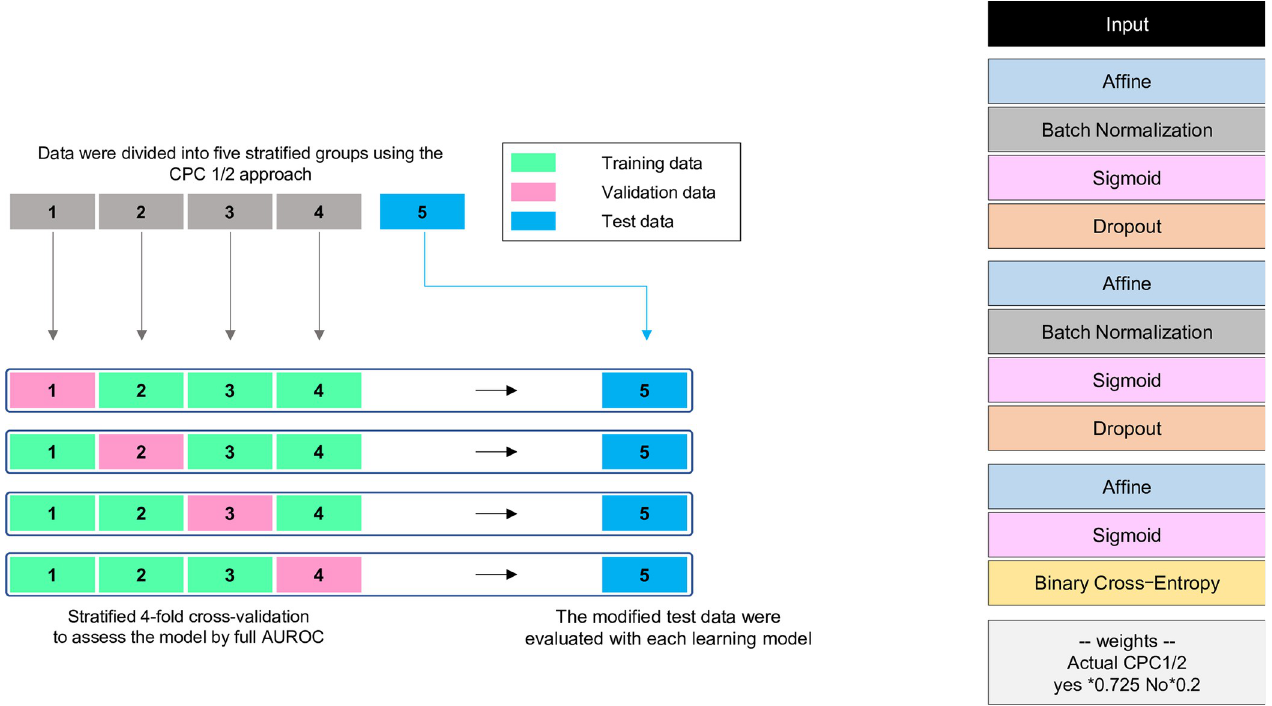
Fig 1. Overview of the data partitioning and stratified cross-validation method and neural network-based machine learning model. The model was developed using the stratified cross-validation method with CPC1/2. The machine learning model comprised a three-layer neural network, along with class weighting to improve the predictive precision for imbalanced data. CPC, cerebral performance category; BN, batch normalization; AUROC, area under the receiver operating characteristics curve.